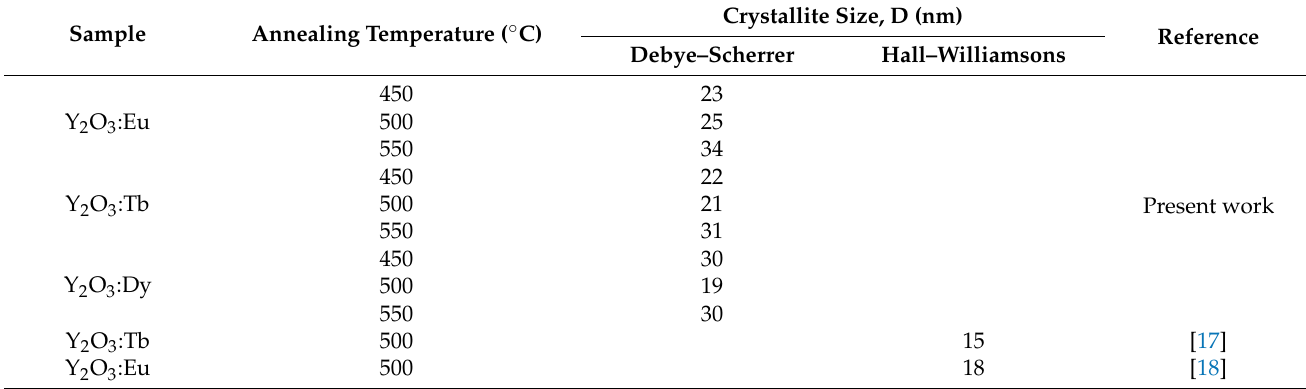
Table 1. Structural parameters of the RE 3+ -doped